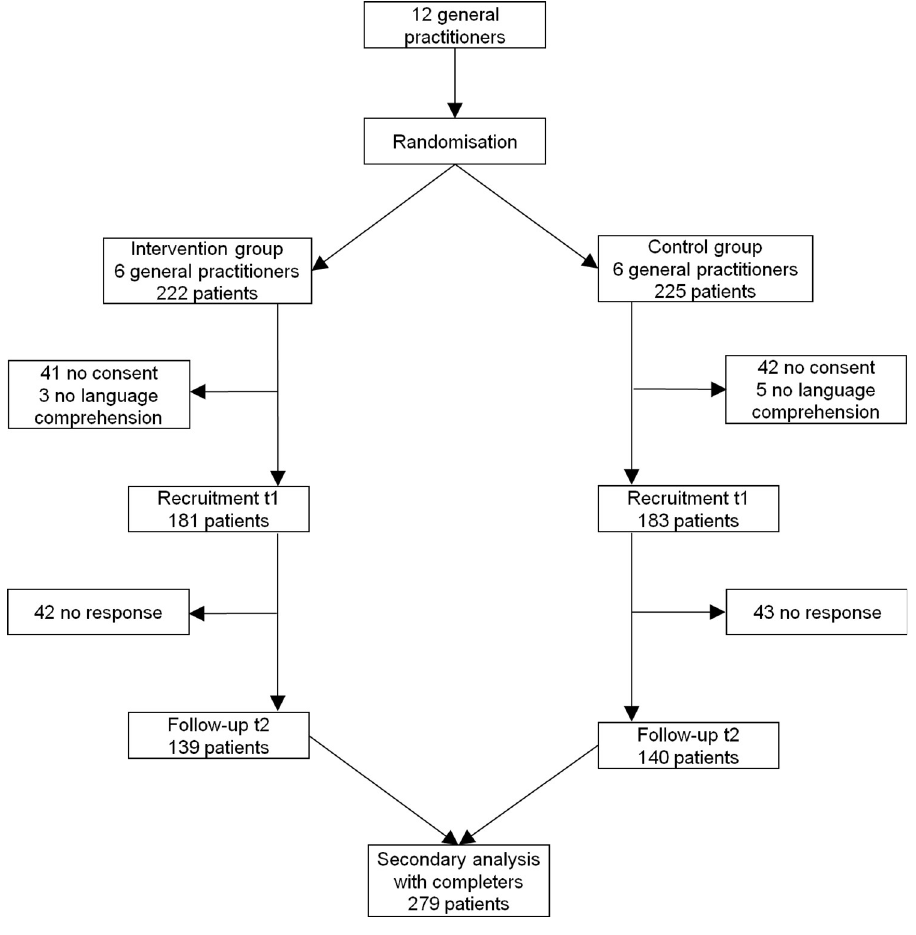
Fig 1. Flowchart of